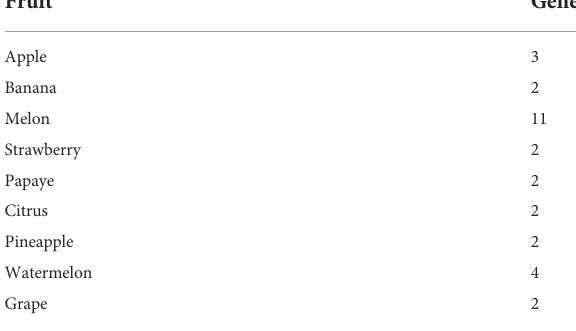
TABLE 2 The fruits selected for study and number of carbamoyltransferase genes identi fi ed in them.